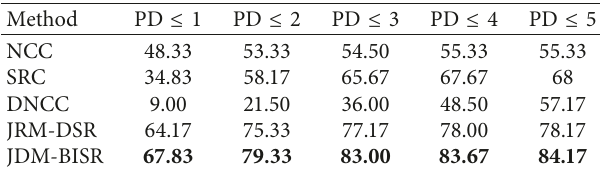
Table 5: Image deblurring results comparison in terms of PSNR. Method